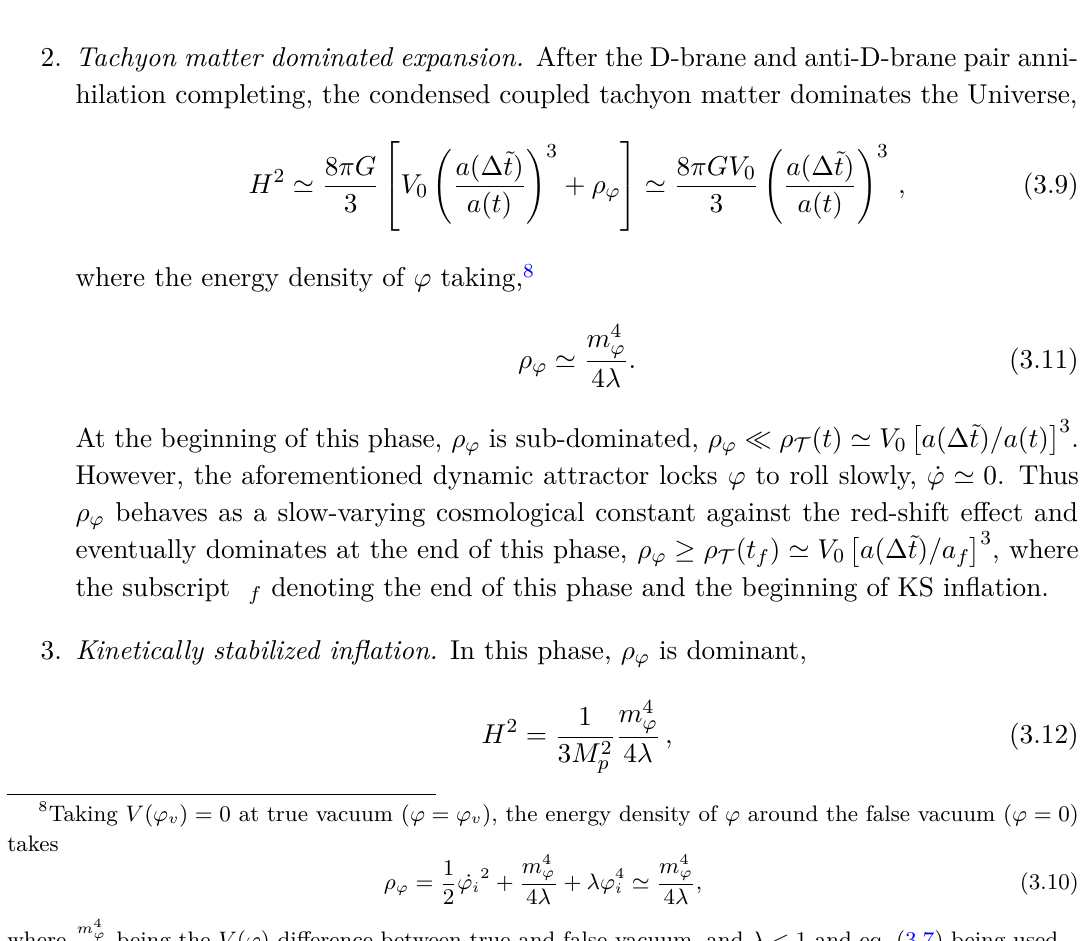
Figure 3 . The parametric plot of ˙ ϕ and ¨ ϕ obtained by numerically solving eq. (3.2) and eq. (3.3), which illustrates that the dynamic attractor of the coupled tachyon field ( ( ˙ T , ¨ T ) = (1 , 0) ) can lock ϕ around the slow-roll condition ˙ ϕ = 0 . The smallest curve is plotted with the initial con- dition ( T (0) , ˙ T (0) , ϕ (0) , ˙ ϕ (0)) = (0 . 001 , 0 . 001 , 10 − 8 , 0) and the other two curves are plotted with (0 . 1 , 0 . 05 , 3 × 10 − 8 , 0) and (0 . 05 , 0 . 1 , 2 × 10 − 8 , 0) respectively. In this numerical simulation, we have neglected the red-shifted term ( 3 H ) for the expanding phase and neglected the λϕ 4 term near ϕ ' 0 region for